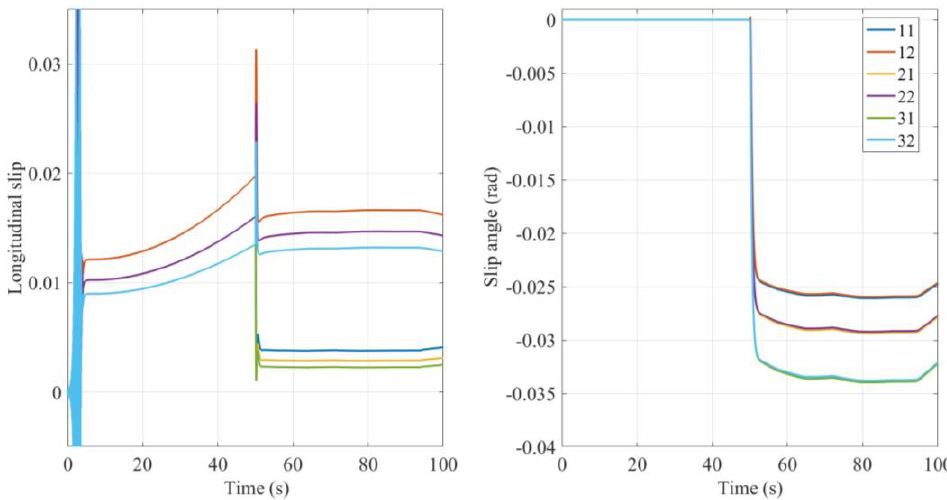
Figure 14. Longitudinal slip ratio and the slip angle under simulation conditions.